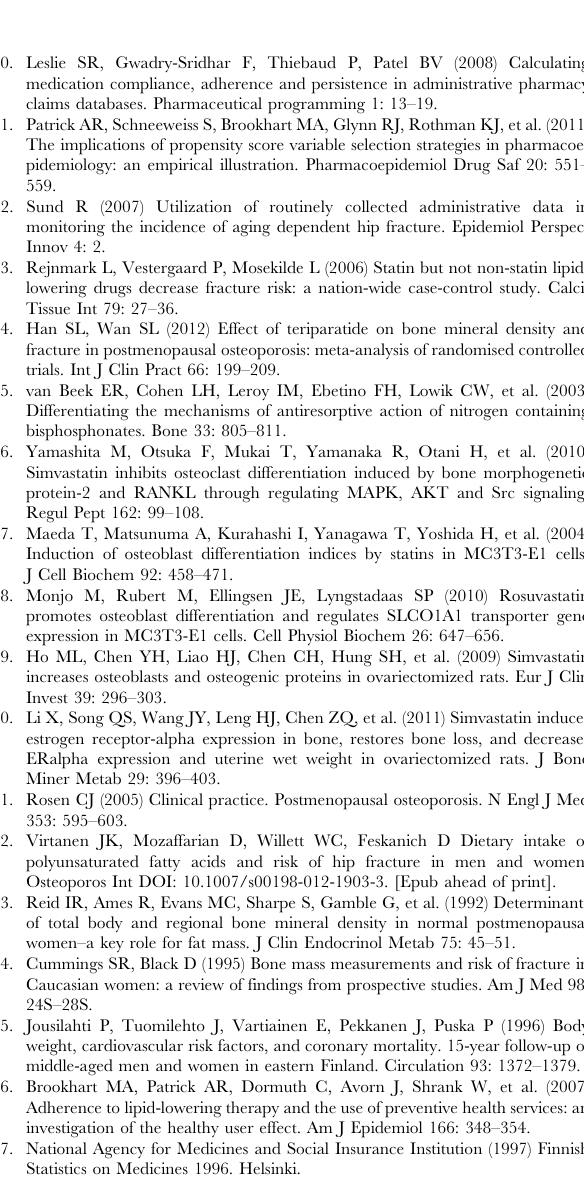
Table S1 Selected characteristics of the persons in the study cohorts. Table S2 Selected characteristics of the persons within the statin